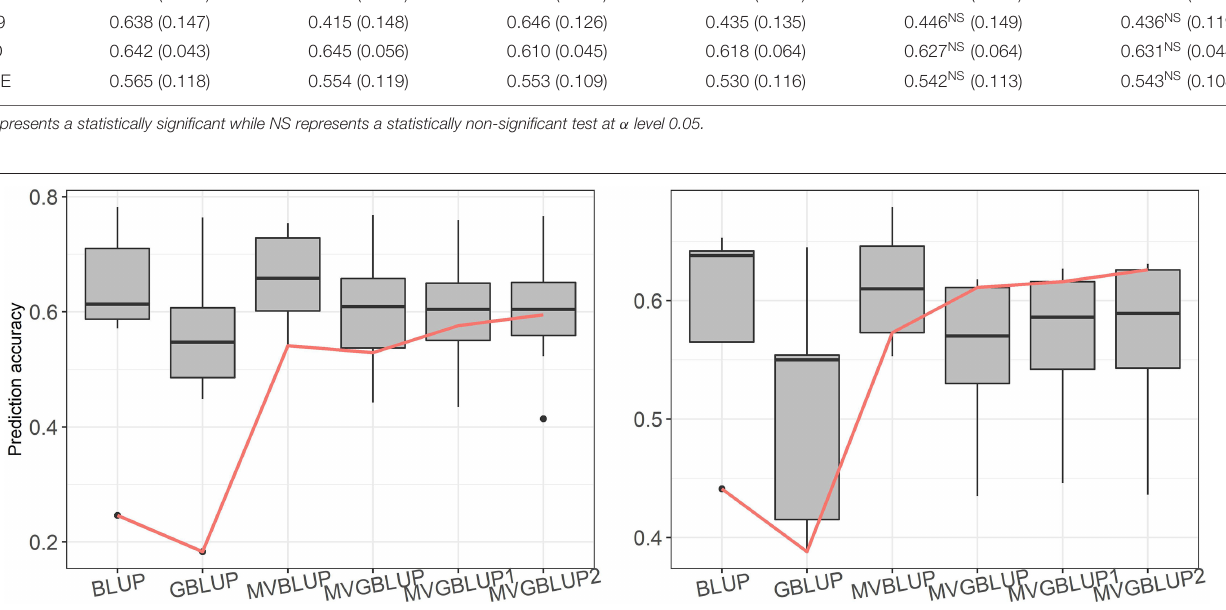
FIGURE 4 | Boxplot of prediction accuracies for each tested scenario in E. nitens (left plot) and in P. radiata (right plot) populations, red line represents prediction accuracy for primary trait